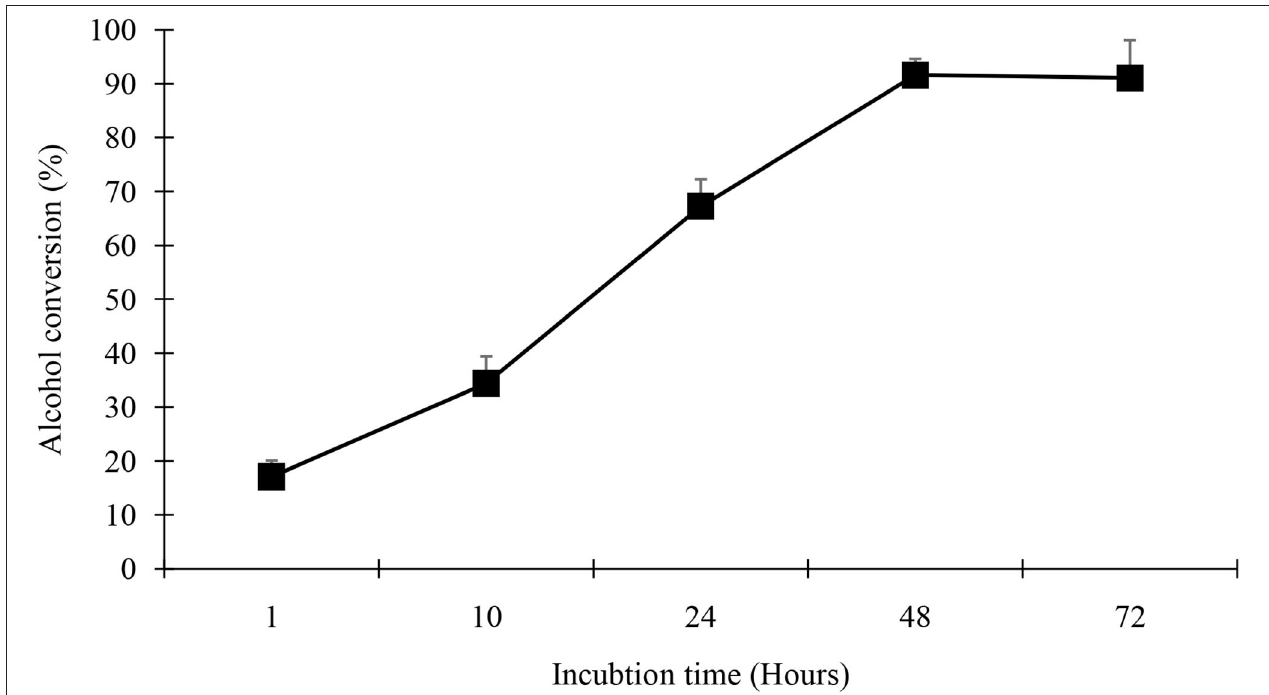
FIGURE 7 | Time course of geranyl butyrate synthesis. The reaction mixture consisted of 0.25M of butyric acid and 0.25M of geraniol with 0.25g of black cumin seedling acetone powder at 37 ◦ C. All experiment were done in triplicate and the values reported are means of three determination.